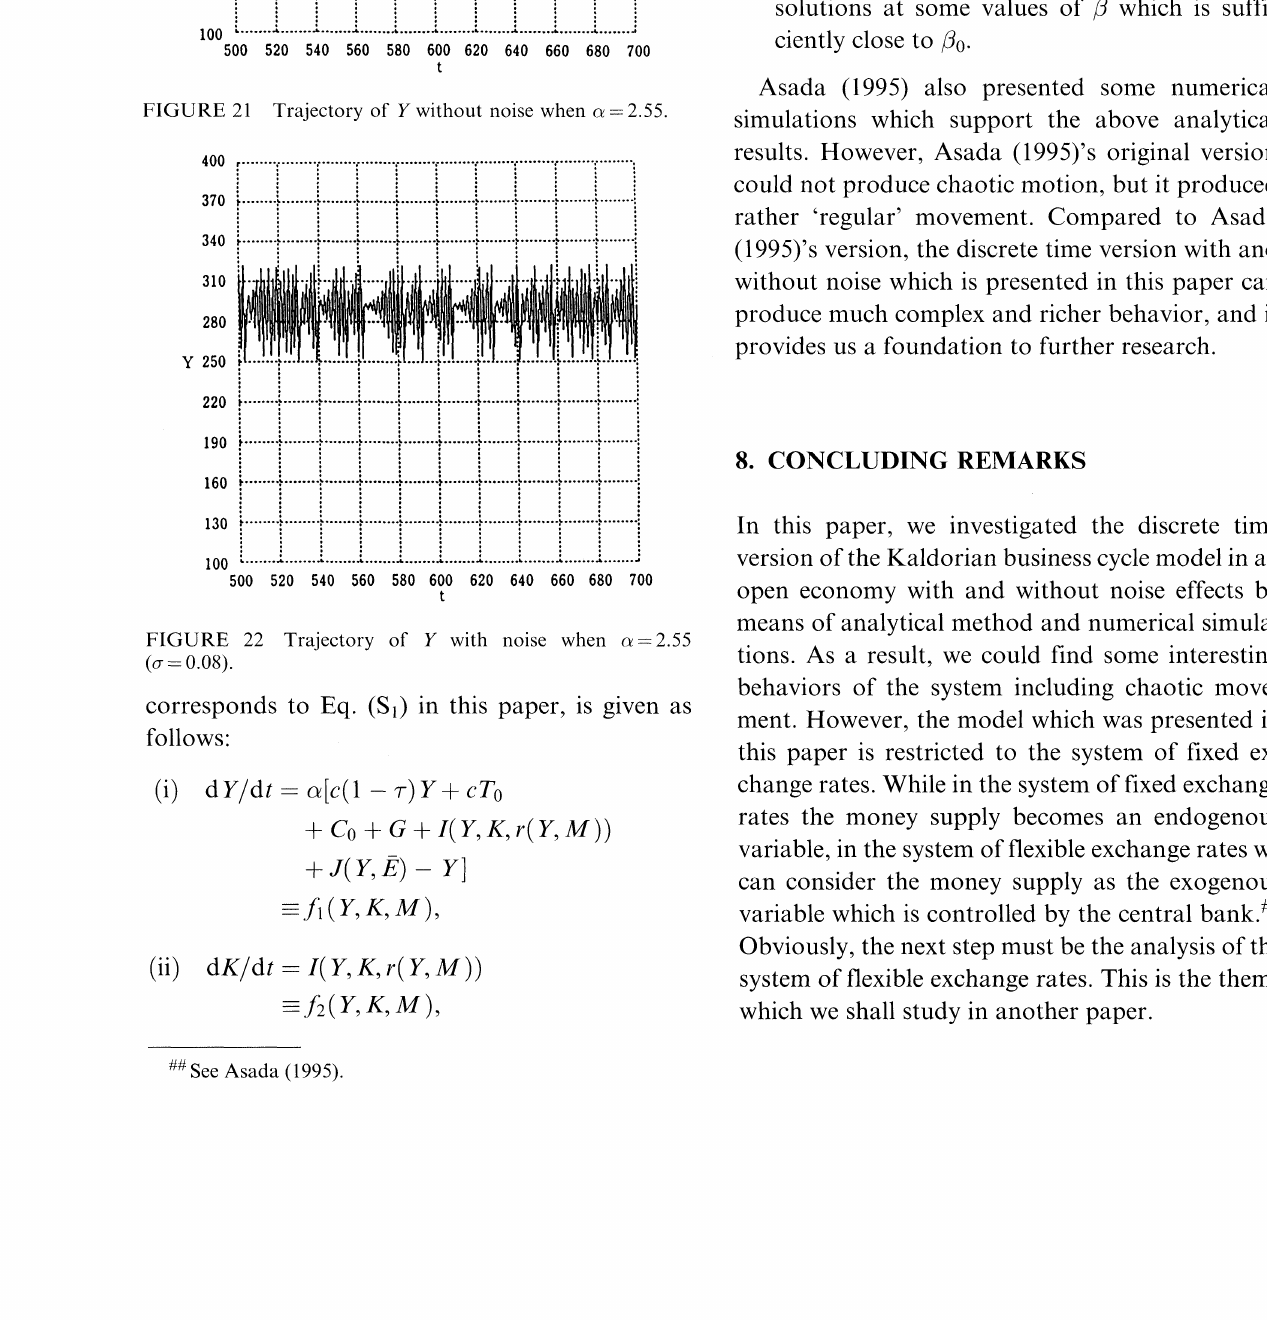
FIGURE 21 Trajectory of Y without noise when c= 2.55.